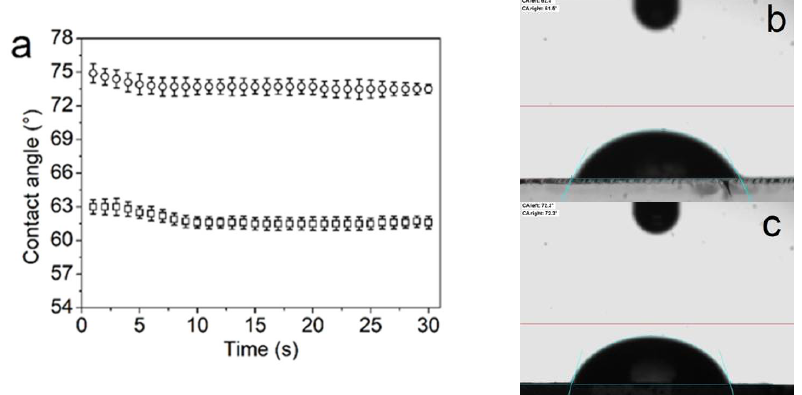
Figure 2. Contact angles of water as a function of contact time ( a ) for GO (squares) and rGO-g (circles) films; photograph of water droplet on GO ( b ) and rGO-g ( c ) films.